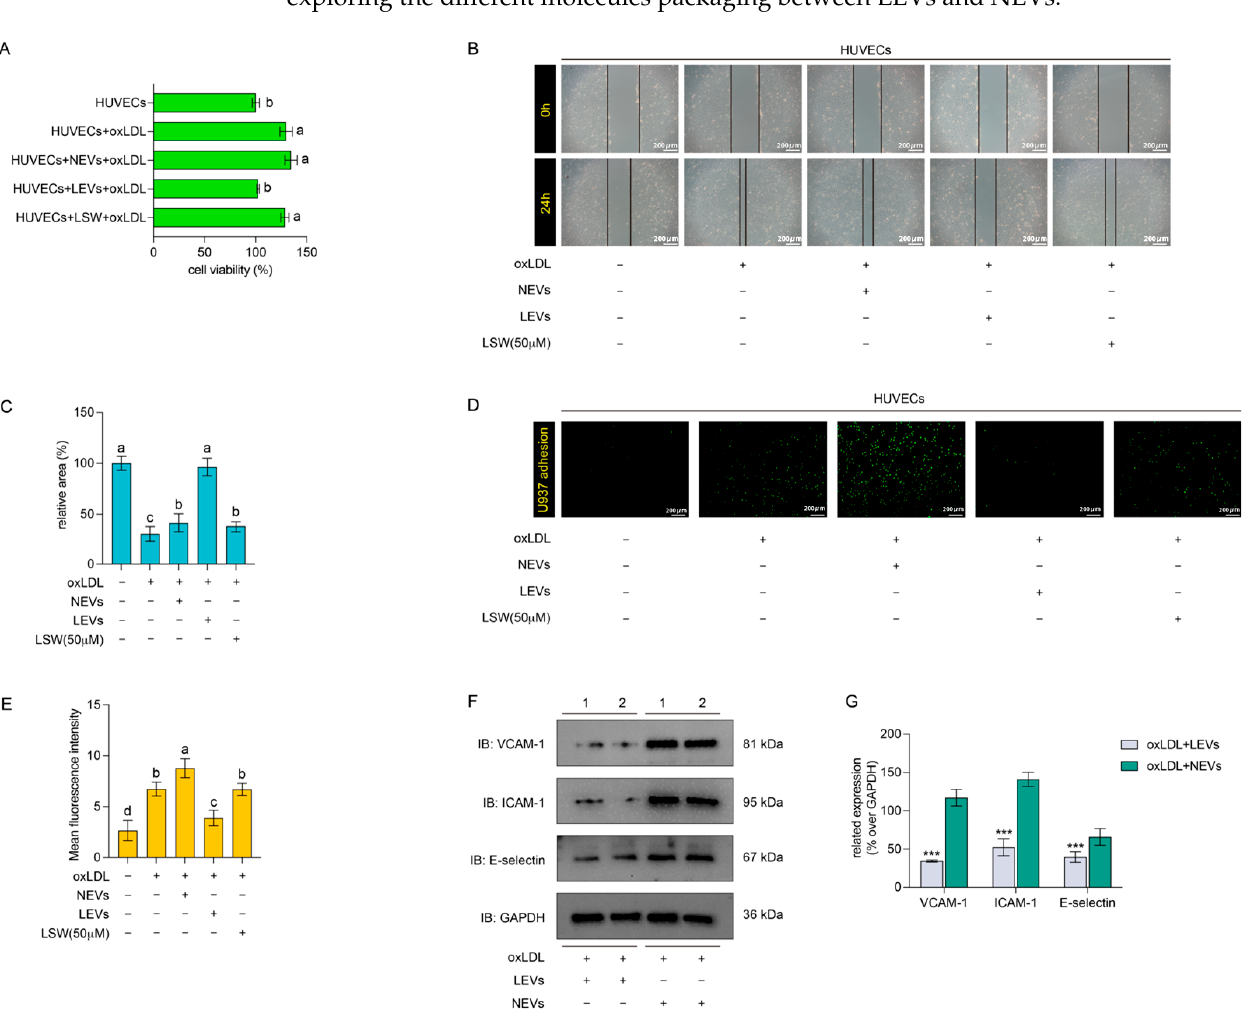
Figure 3. The different regulations of small EVs and LSW on the proliferation, migration, and adhesion of HUVECs. The HUVECs were pre-treated by EVs or LSW for 12 h prior to stimulation with oxLDL. ( A ) The relative cell viabilities of the HUVECs pre-treated with EVs or LSW in presence of oxLDL, and it is significantly different ( p < 0.05) with different alphabetical mark. ( B ) The macroscopic images of wound healing on 0 and 24 h (100 × magnification, scale bar: 200 µ m). The scratch was created on the HUVECs and the wound closure was monitored with the application of NEVs, LEVs, and LSW. ( C ) The relative area of the wound healing scratch at 24 h was measured by ImageJ software and the results of each treatment group were shown to the normal HUVECs without special